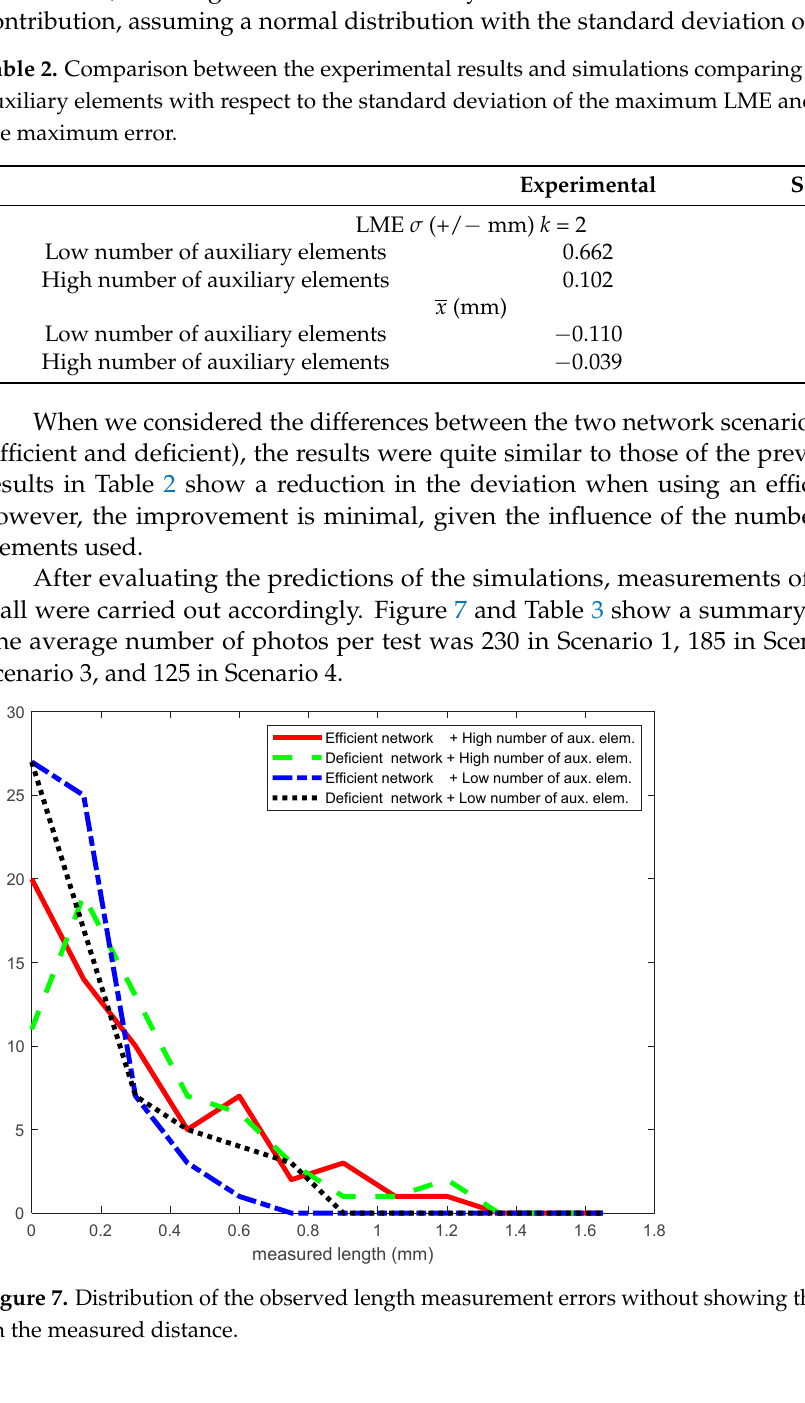
Figure 8. Errors of the deficient network and high-level extrinsic parameters. As mentioned in the previous section, one of the studied variables did not follow the expected trend. The LME and the average error between the high and low numbers of auxiliary elements contradicts the expected behaviour predicted in Figure 8. Studying the procedures of the tests allowed a possible reason for the results to be identified. In Scenarios 1 and 2, the user took photos at a closer distance than in Scenarios 3 and 4, as this was possible due to the number of auxiliary elements (see Table 4 to identify the scenarios). Consequently, an excessive drift may have been generated, which would have resulted in larger length measurement errors.